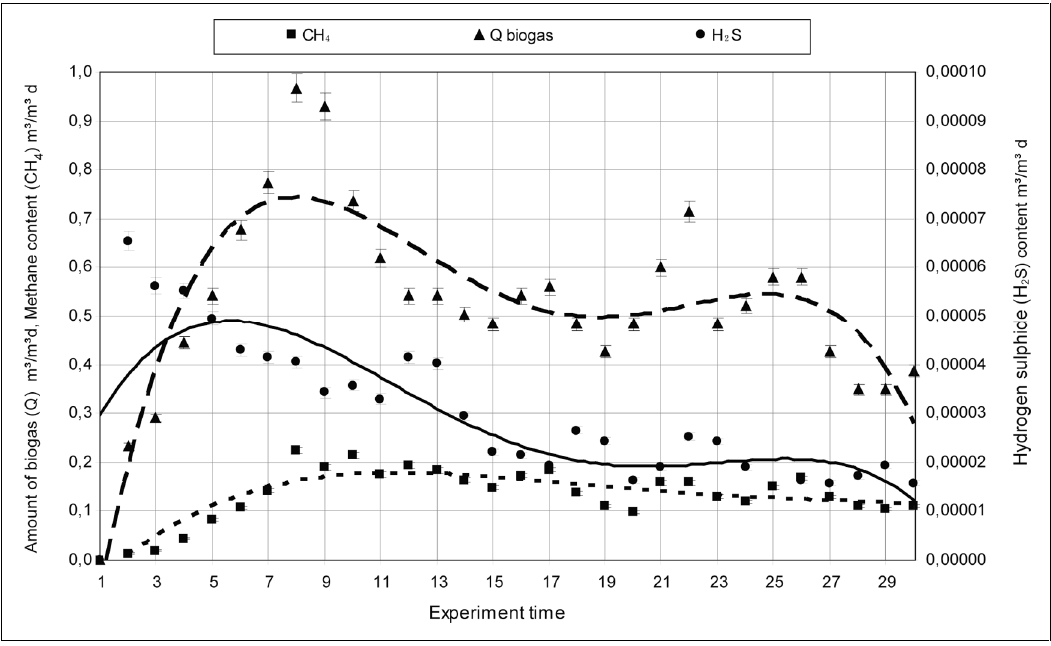
3 3 3 3 /m d), methane (m /m d) and hydrogen sulphide (m